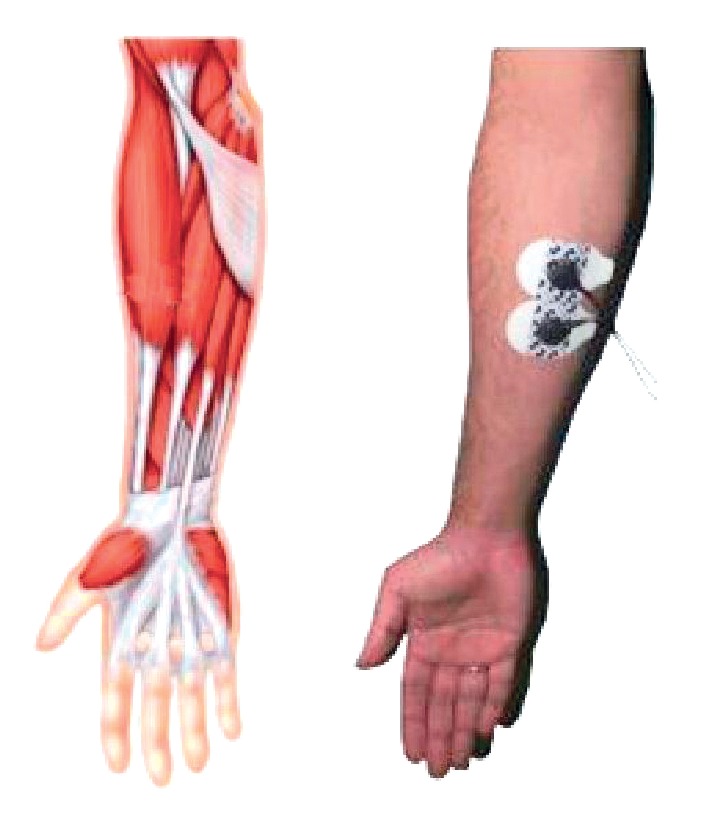
Surface electromyography example [2].